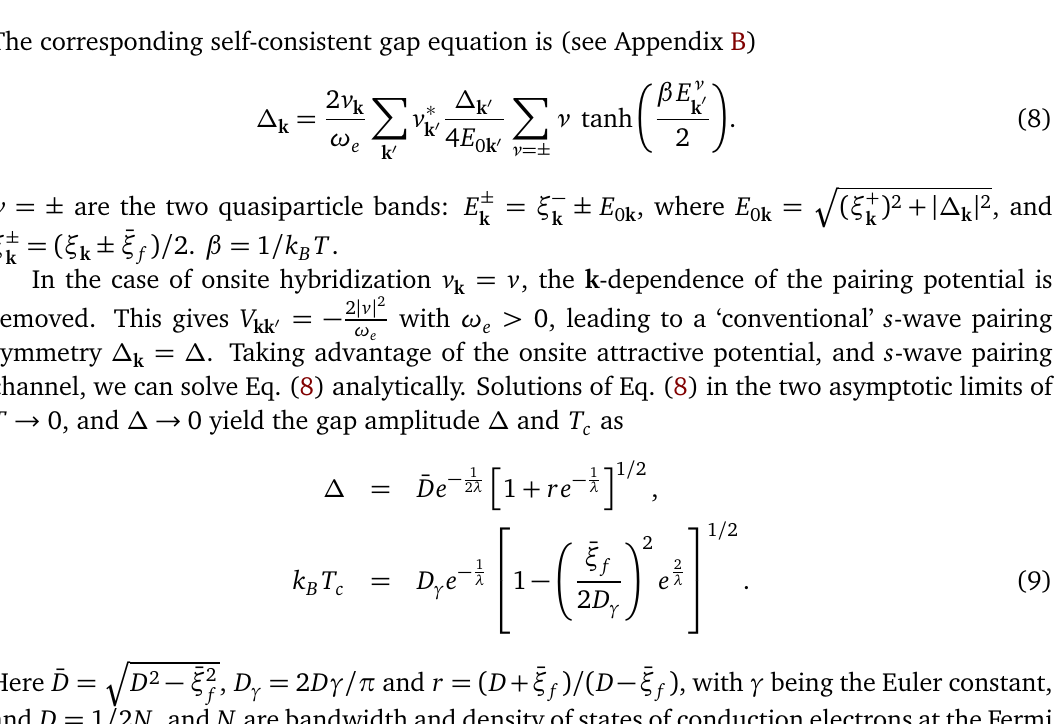
Figure 2: SC phase diagram with respect to valence fluctuation potential v and renor- malized f -electron’s energy ¯ ξ . (a), The SC transition temperature T is plotted in f c the ( v , ¯ ξ ) space, scaled with respect to the conduction electron’s bandwidth D . We f / D = − 0.1. The white region for small values of v gives the SC-forbidden re- set ξ f gion (Eq. (11)). (b), SC gap amplitude ∆ (at T = 0) plotted in the same parameter space. Above the critical value of v , both T and ∆ grows with v 2 as in Eq. (9). Inter- c estingly, optimal superconductivity commences at a finite value of ¯ ξ where all the f → 0, and the pairing potential V → ∞ holon fields condense to ω e